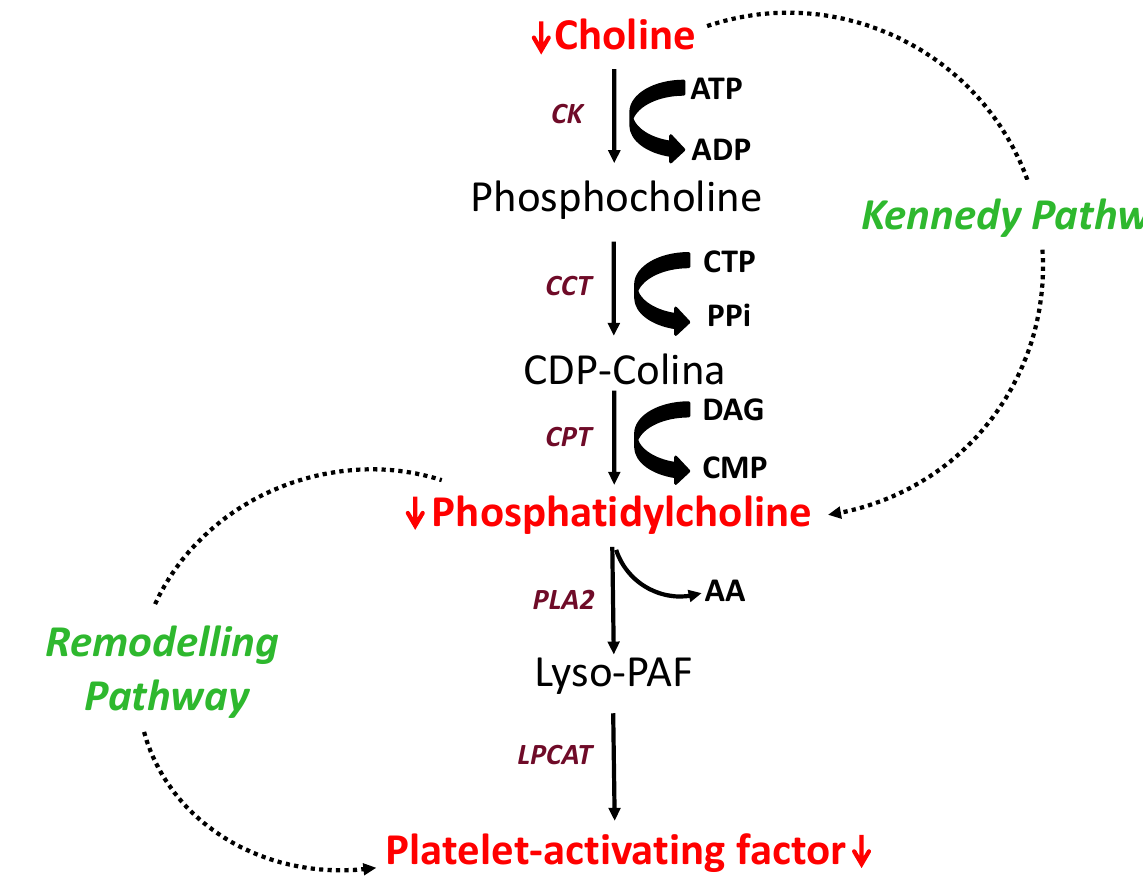
Figure 3. Regulation of Kennedy and remodeling pathways: PCSK9 inhibitor treatment blocks platelet-activating factor biosynthesis by regulating the Kennedy and remodeling pathways. Choline reduction reduces phosphatidylcholine (PC) synthesis, resulting in reduced platelet activating factor (PAF) production. Abbreviations: CK = choline kinase; CTP = cytidine triphosphate; CCT = CTP:phosphocholine cytidylyltransferase; CDP-choline = cytidine diphosphocholine; CPT = CDP-choline:1,2-diacylglycerol choline-phosphotransferase; DAG = diacylglycerol; PLA2 = phospholipase a 2; AA = arachidonic acid; LPCAT = lysophosphatidylcholine acyltransferase. Solid arrow means transformed; red arrow means reduced.